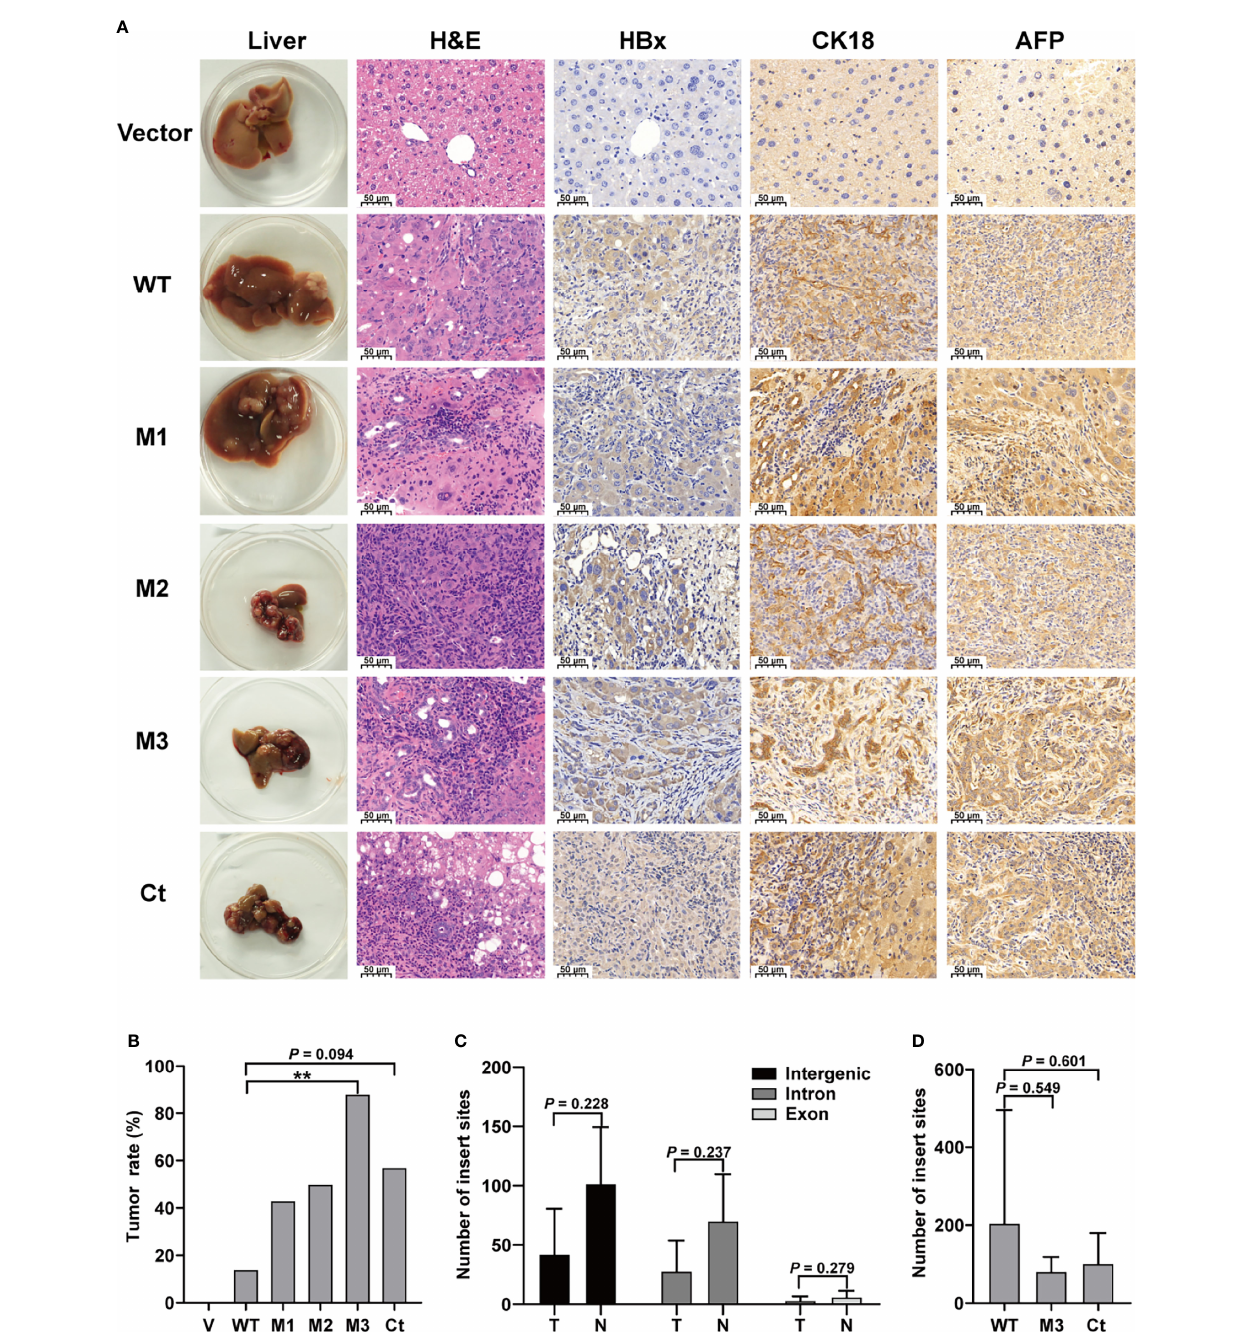
FIGURE 2 | The pathological characteristics, tumor occurrence, and the insertion sites of HBx fragment in Sleeping Beauty (SB) mouse models. (A) Representative images of H&E and IHC staining. The fi rst column shows representative gross features indicating the tumors in the livers. The second column shows representative H&E stainings indicating the histological features of the livers. The third to fi fth columns show representative IHC stainings for HBx, CK-18, and AFP. Vector, the mice injected with the empty vector; WT, M1, M2, M3, and Ct, the mice injected with vectors carrying WT-HBx, M1-HBx, M2-HBx, M3-HBx, and Ct-HBx, respectively. (B) Incidence of tumors in the mouse models. V, the mouse models injected with the empty vector, n=7; WT, the mouse models injected with WT-HBx, n=7; M1, the mouse models injected with M1-HBx, n=7; M2, the mouse models injected with M2-HBx, n=4; M3, the mouse models injected with M3-HBx, n=8; Ct, the mouse models injected with Ct-HBx, n=7. (C) The number of HBx insertion sites in different functional regions and different tissue types. T, tumors from the mice with tumor nodules; N, liver tissues from the tumor-free mice. (D) The total number of HBx insertion sites between two of the three groups. ** P <